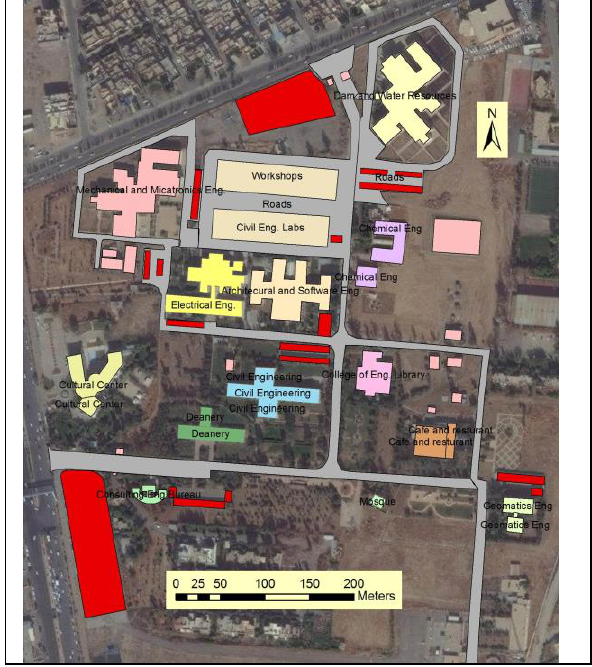
Figure 1. Digitised buildings of the study area, as shown by free world satellite imagery (image sources: Esri, DigitalGlobe, GeoEye, Earthstar Geographics, CNES/Airbus DS, USDA, USGS, AEX, Getmapping, Aerogrid, IGN, IGP, swisstopo and the GIS User Community).